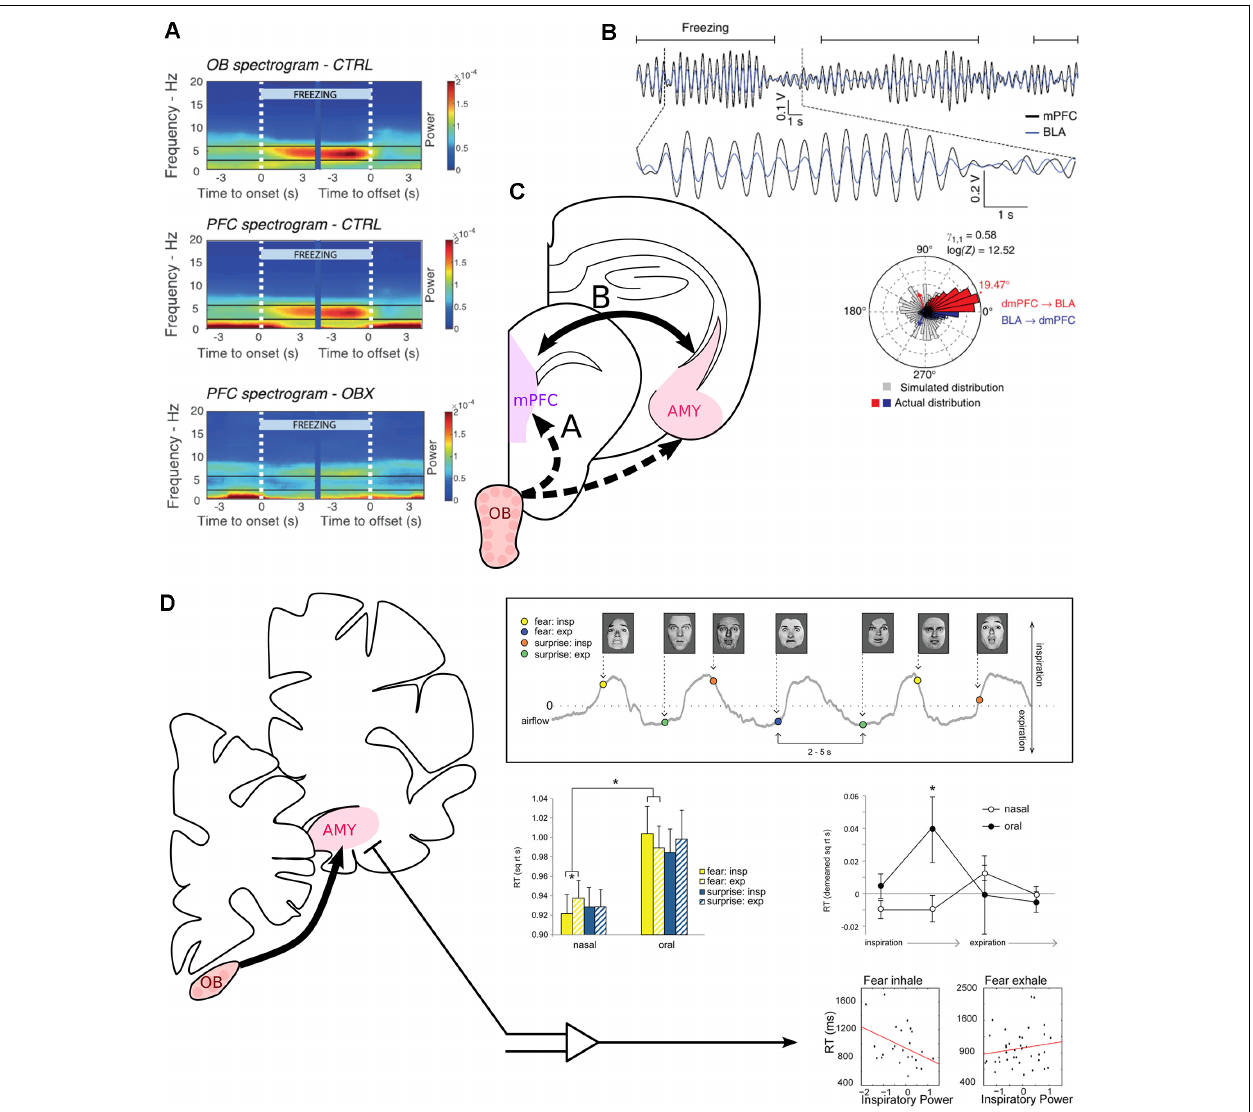
FIGURE 3 | Modulation of fear-related neural correlates and recognition of fearful faces by respiration. (A) The mPFC is entrained at 4 Hz by RR sensorial afferences during freezing. Spectrogram averaged across mice at freezing onset and offset, indicated by the white vertical dashed lines. Power spectra of the OB (top) and medial prefrontal cortex (PFC, middle) of control mice. Bottom: Power spectrum of the PFC of mice after bulbectomy. Reprinted from Bagur et al. (2021) under CC BY 4.0. (B) The mPFC and the basolateral amygdala (BLA) are highly coherent at 4 Hz during freezing. Top: Bandpass filtered 2–6 Hz LFP signals of the mPFC (black) and the simultaneously recorded BLA LFP (blue) during recall of conditioned fear. Freezing epochs are indicated by the horizontal black lines. Bottom: Phase difference between the mPFC and the amygdala (Red: above 0 ◦ of phase difference, mPFC phase precedes BLA phase. Blue: Below 360 ◦ , BLA phase precedes mPFC phase. Gray: simulated phase differences obtained by bootstrapping). Adapted by permission from Springer Nature, Nature Neuroscience, Karalis et al. (2016), copyright (2016). (C) The periamygdaloid cortex receives direct projection from the OB. BLA units are furthermore paced by RR in the home cage (Karalis and Sirota, 2018). (D) Inspiration facilitates the recognition of fearful faces. Top right, experimental paradigm: subjects had to discriminate between fearful or surprised faces presented at jittering interval of 2–5 s during nasal or oral breathing (gray line). Middle left: reaction time to recognize expressions for each emotion (yellow: fear, blue: surprise), depending on the phase of respiration (full: inspiration, dashed: expiration) and the breathing route. Middle right: Detrended reaction time for the recognition of fear for four phases of the breathing cycle. Oral breathing induced an increase in the reaction time during late inspiration. Bottom: Correlation between reaction time and the mean z-scored power in the delta band during the whole inspiration or expiration time window. On the left, “Fear inhale” shows the results for fearful faces presented during inspiration, and “Fear exhale” the results for fearful faces presented during expiration. Reprinted from Zelano et al. (2016) under CC BY 4.0. ∗ p <